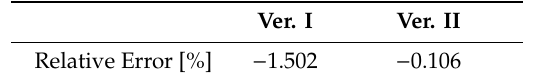
Table 2. Relative error of modal analysis results with experimental results [%].